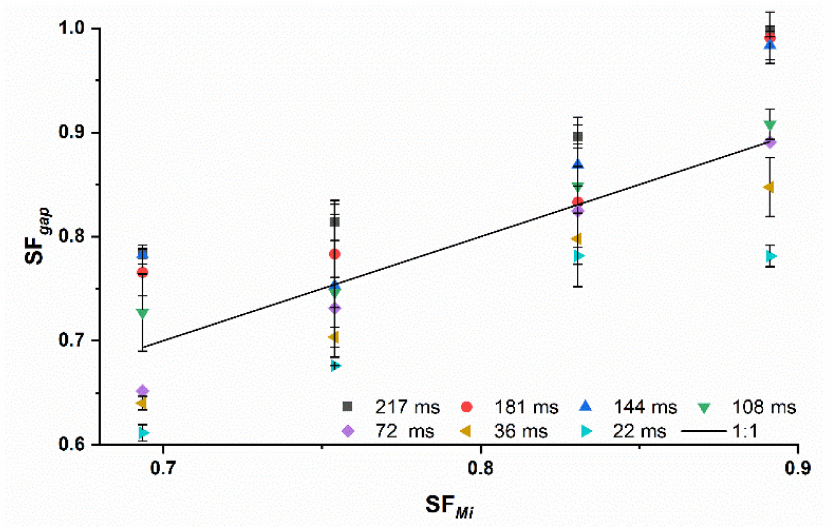
Figure 5. Measured SF gap off MCC ribbons with changing dwell times compared to the predicted ribbon solid fraction of the Midoux number SF Mi (solid black line); x ± s ; n =